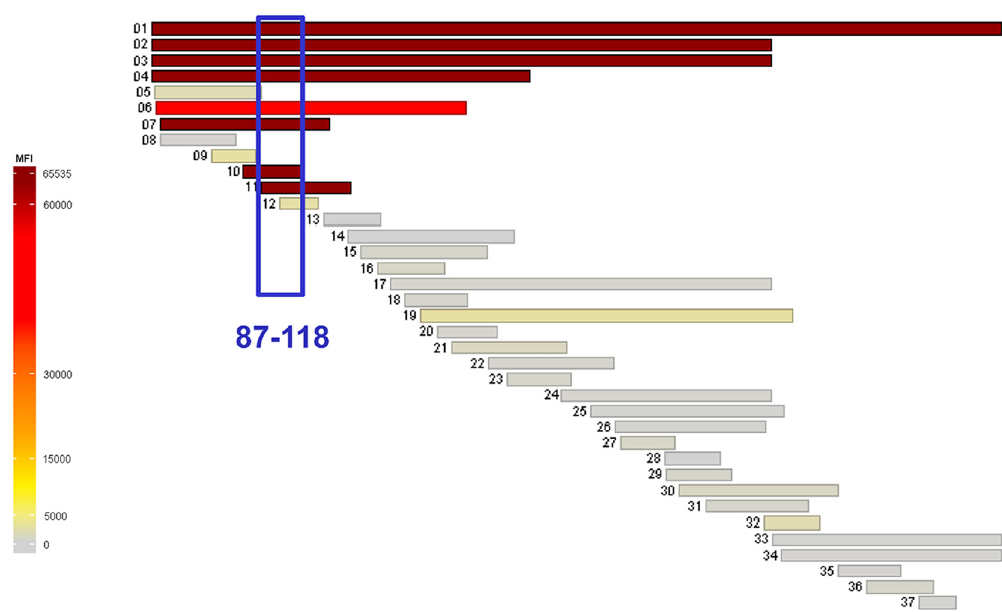
Fig 4. Immunoreactivity of mAb 31E10/E7 to a panel of recombinant NHBA-NUbp fragments spotted in a microarray. Each horizontal bar represents a protein or protein fragment in the microarray aligned along the NHBA-NUbp sequence and color-coded from light grey to dark red according to mean fluorescence intensity (MFI) values, as shown in the vertical bar. The blue box indicates the sequence shared by all positive fragments (A87-S118). Shown are MFI values from one experiment representative of three, each performed using 8 replicates per protein. Raw data from all experiments are available under accession number GSE81379 at the National Center for Biotechnology Information ’ s Gene Expression Omnibus